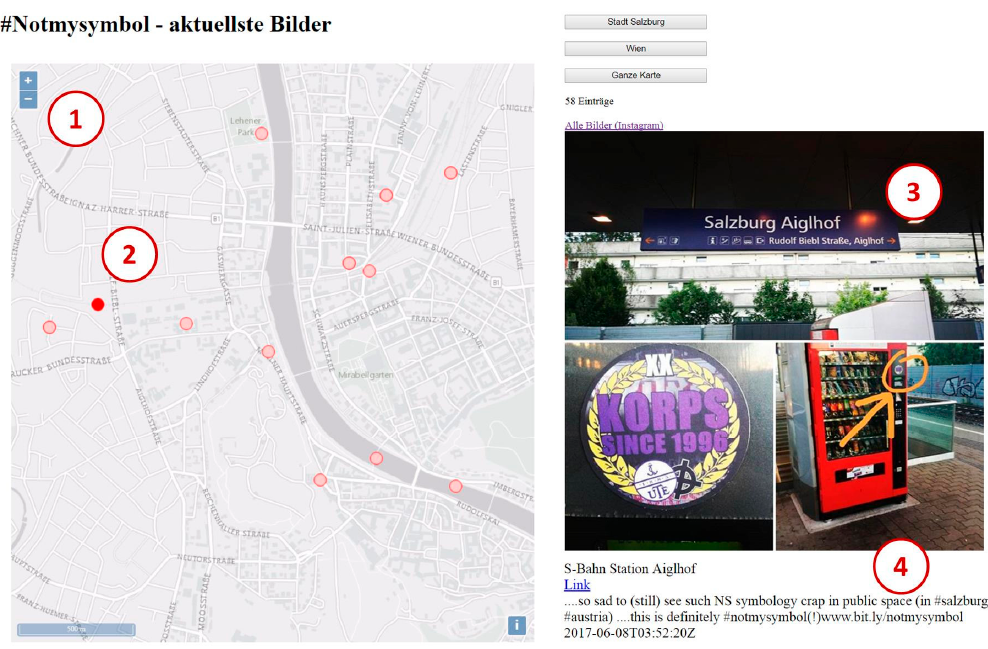
Figure 3. Results of the collaborative mapping-process on the example of the inner city of Salzburg (Austria) displayed on a mapping application prototype: ( 1 ) delivering a map interface including all collected symbols, ( 2 ) highlighting the selected post, ( 3 ) showing the photo of the selected post uploaded to Instagram, and ( 4 ) delivering the location, the direct link to the original Instagram post and embedding the comment added to the Instagram post by the uploading user (screenshot from the mapping application prototype: [48]).